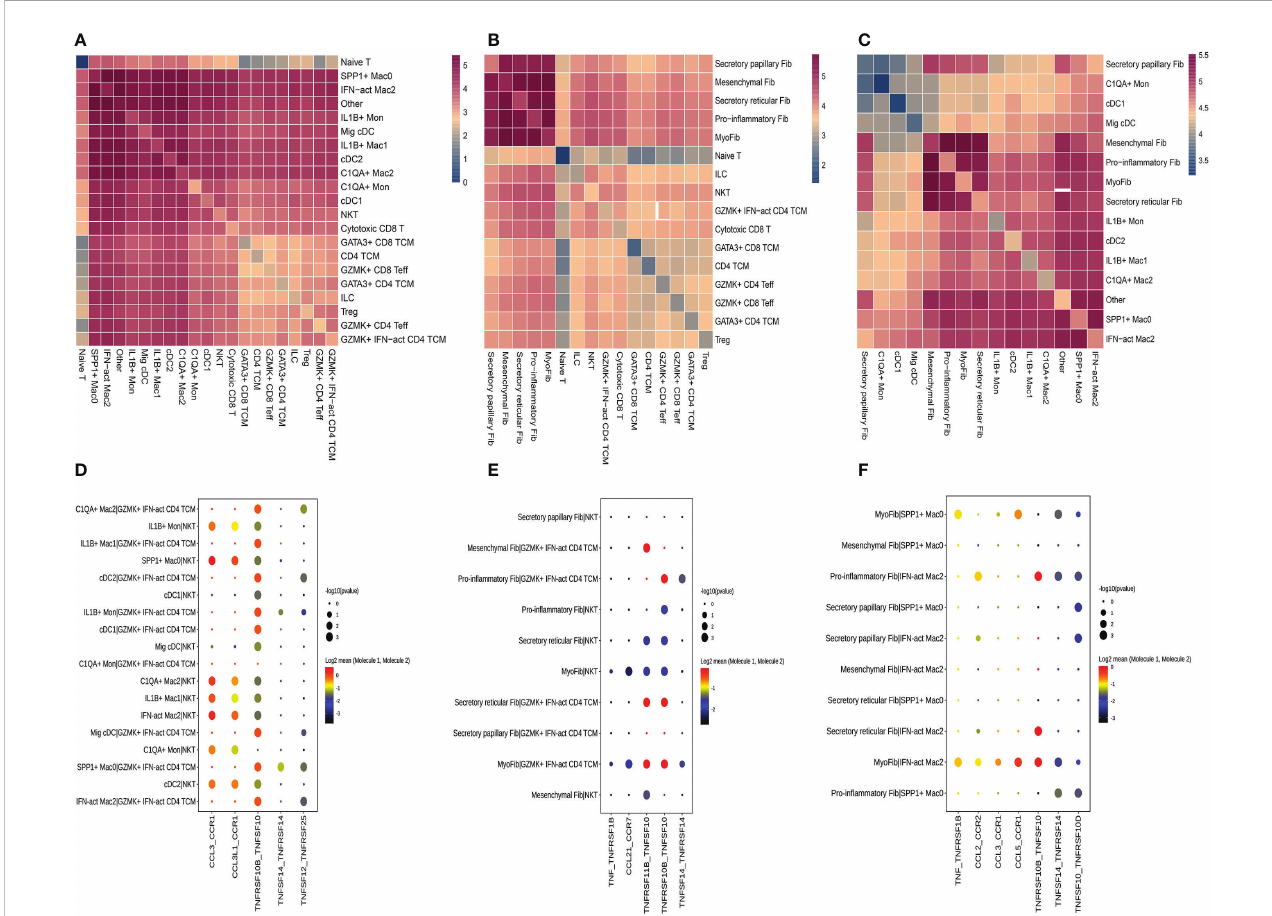
FIGURE 9 Crosstalk among T cell, fi broblasts and myeloid cell. (A) Heatmap presents the key cellular interaction between T cell and myeloid cell. (B) Heatmap presents the key cellular interaction between T cell and fi broblasts. (C) Heatmap presents the key cellular interaction between fi broblasts and myeloid cell. (D) Dot plot shows the signi fi cant ligand-receptor pairs between T cell subsubsets and myeloid cell subsubsets. (E) Dot plot shows the signi fi cant ligand-receptor pairs between T cell subsubsets and fi broblasts subsubsets. (F) Dot plot shows the signi fi cant ligand-receptor pairs between myeloid cell subsubsets and fi broblasts